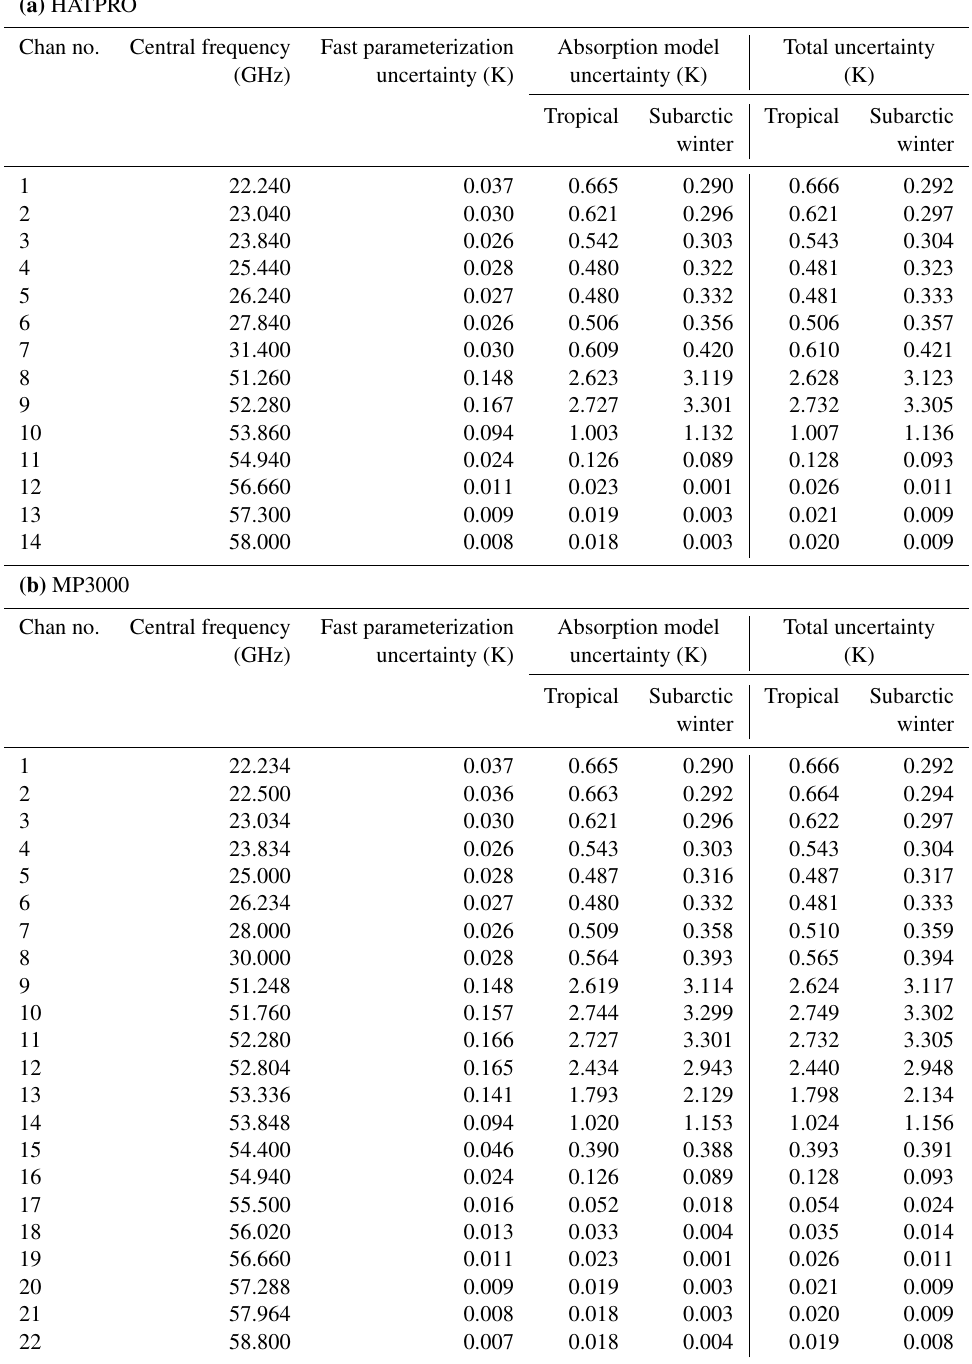
Table 5. RTTOV-gb T B uncertainty due to forward model and fast parameterization and their total squared sum for two extreme climatology conditions. Channels for the four sensors considered in the current version of RTTOV-gb are given in (a) (HATPRO), (b)